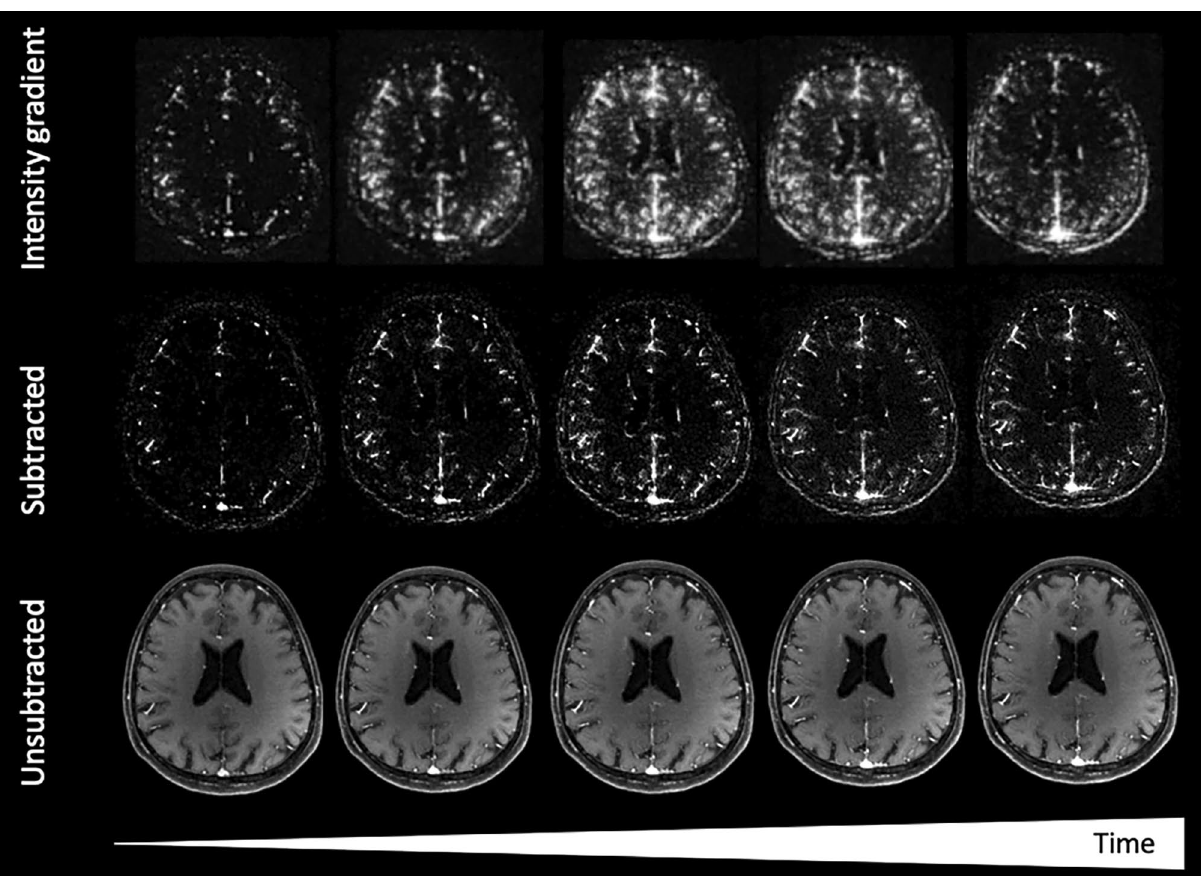
Figure 3. GRASP MRI from a 63-year-old woman imaged for headache reconstructed as time-resolved MRA images, including identifying parenchymal/capillary phase enhancement. Paired subtracted (middle row) and source (bottom row) time-resolved slices at the level of the corona radiata. Accompanying axial slices processed using voxel-wise intensity gradient (top row), as detailed in “Methods”, demonstrate accentuated